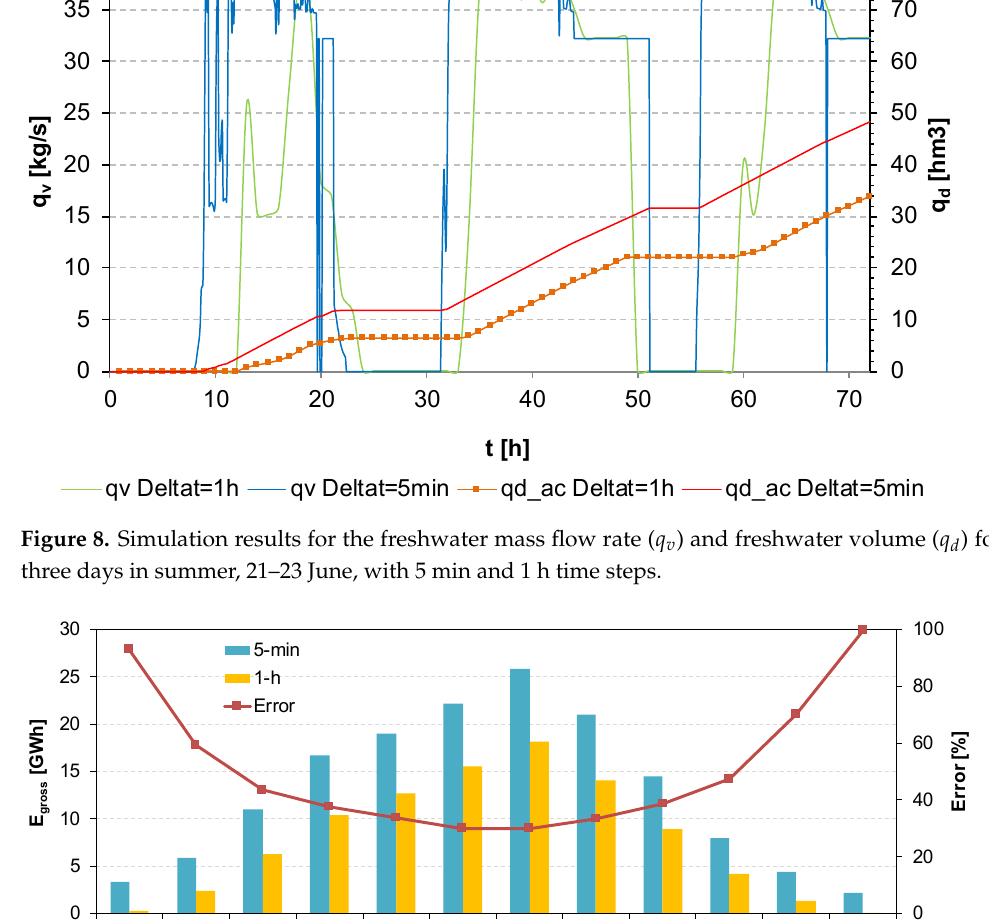
Table 2. Monthly electric gross energy ( 𝐸 (cid:3034)(cid:3045)(cid:3042)(cid:3046)(cid:3046) ) and freshwater production ( 𝑞 (cid:3031) ) as a function of the time step during a year of operation. ε E and ε qd are the relative errors of 𝐸 (cid:3034)(cid:3045)(cid:3042)(cid:3046)(cid:3046) and 𝑞 (cid:3031) , respectively.